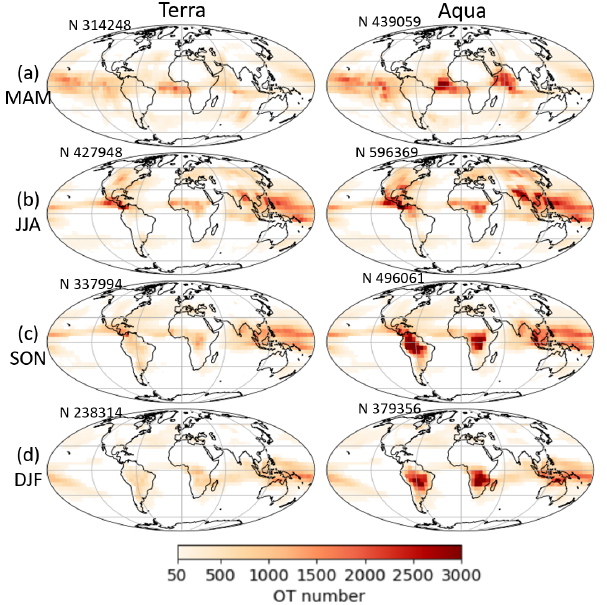
Figure 8. The global distributions of OT occurrences derived from Terra and Aqua MODIS in four seasons. (a) March–April–May (MAM), (b) June–July–August (JJA), (c) September–October– November (SON), and (d) December–January–February (DJF). Grid resolution is 5 ◦ longitude by 5 ◦ latitude. Samples in grids of fewer than 50 pixels are shown in white. N in the upper right corner of each panel stands for sample number.